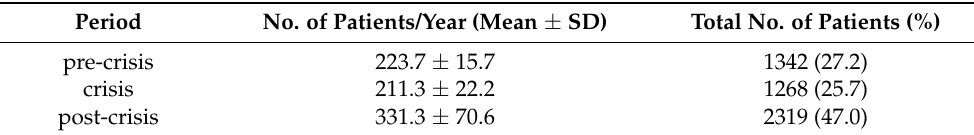
Table 1. Distribution of breast cancer patients by study period.